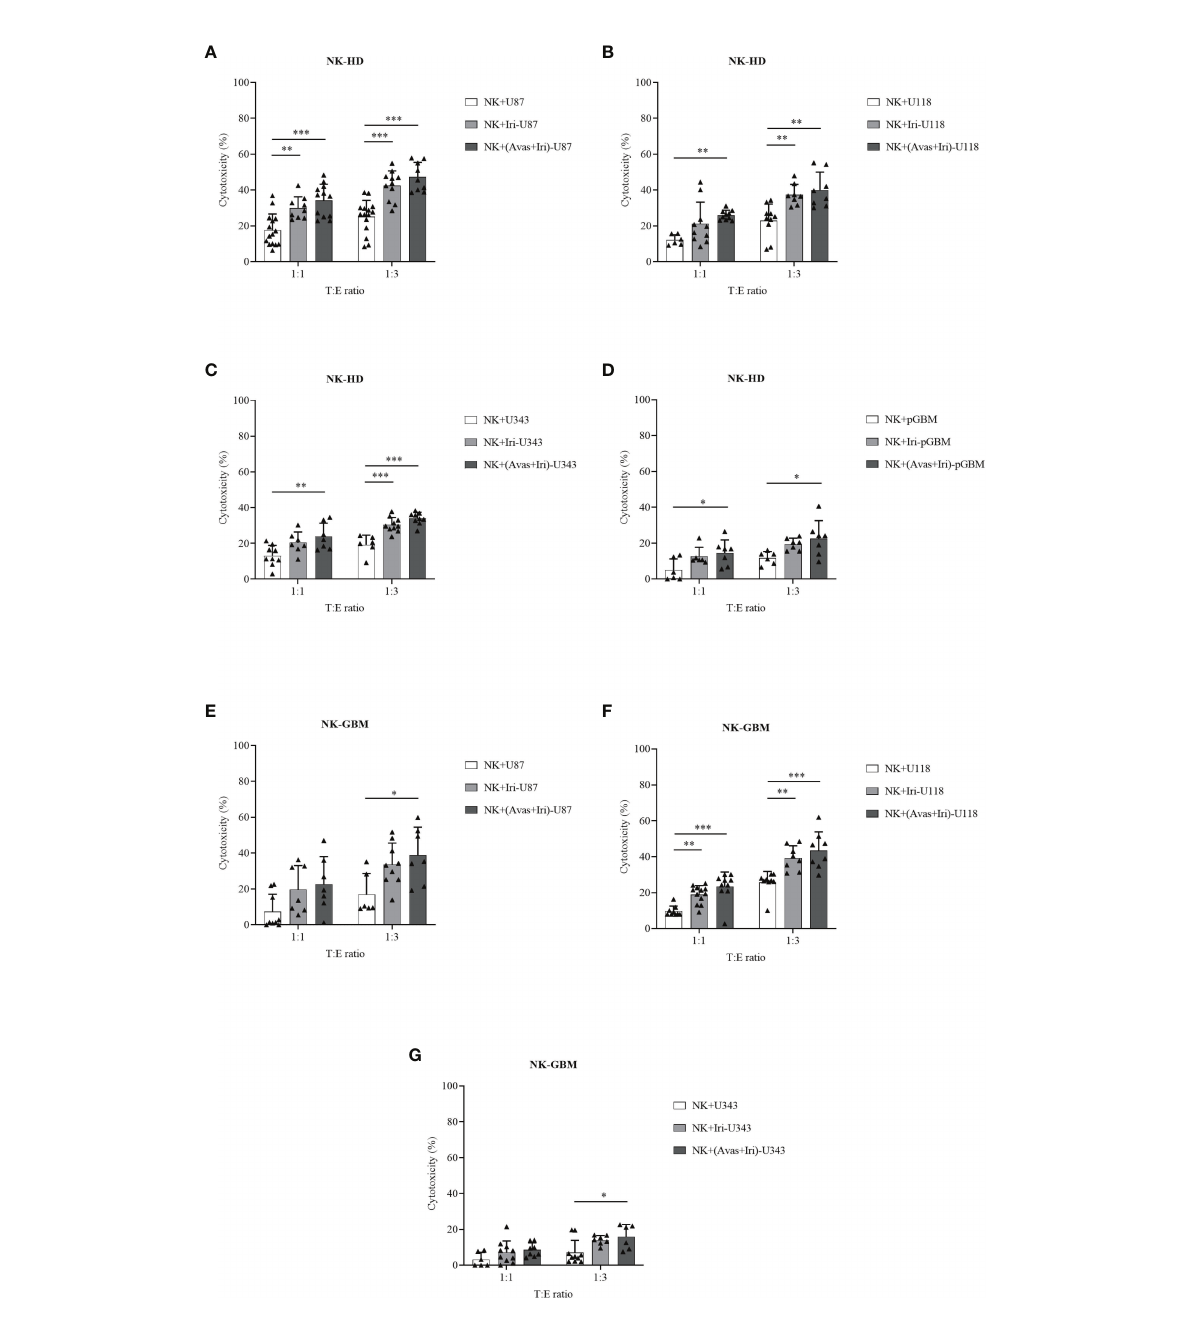
FIGURE 2 Cytotoxic effects of expanded NK cells from HDs (NK-HD) and GBM patients (NK-GBM) against GBM cells, Iri-treated GBM, and Bev plus Iri- treated GBM cells. The cytotoxicity effects of NK-HD (A – D) and NK-GBM cells (E – G) against GBM cells such as U87, U118, U343, pGBM at 1:1 and 1:3 (target:effector) ratio were con fi rmed through the LDH assay. U87, U118, and U343: human GBM cell lines; pGBM: primary GBM cells; Bev: bevacizumab (0.5 mg/mL); Iri: irinotecan (0.15 mg/mL). All data are shown as mean ± SD. p< 0.05 (*), p< 0.001 (**), p< 0.0001